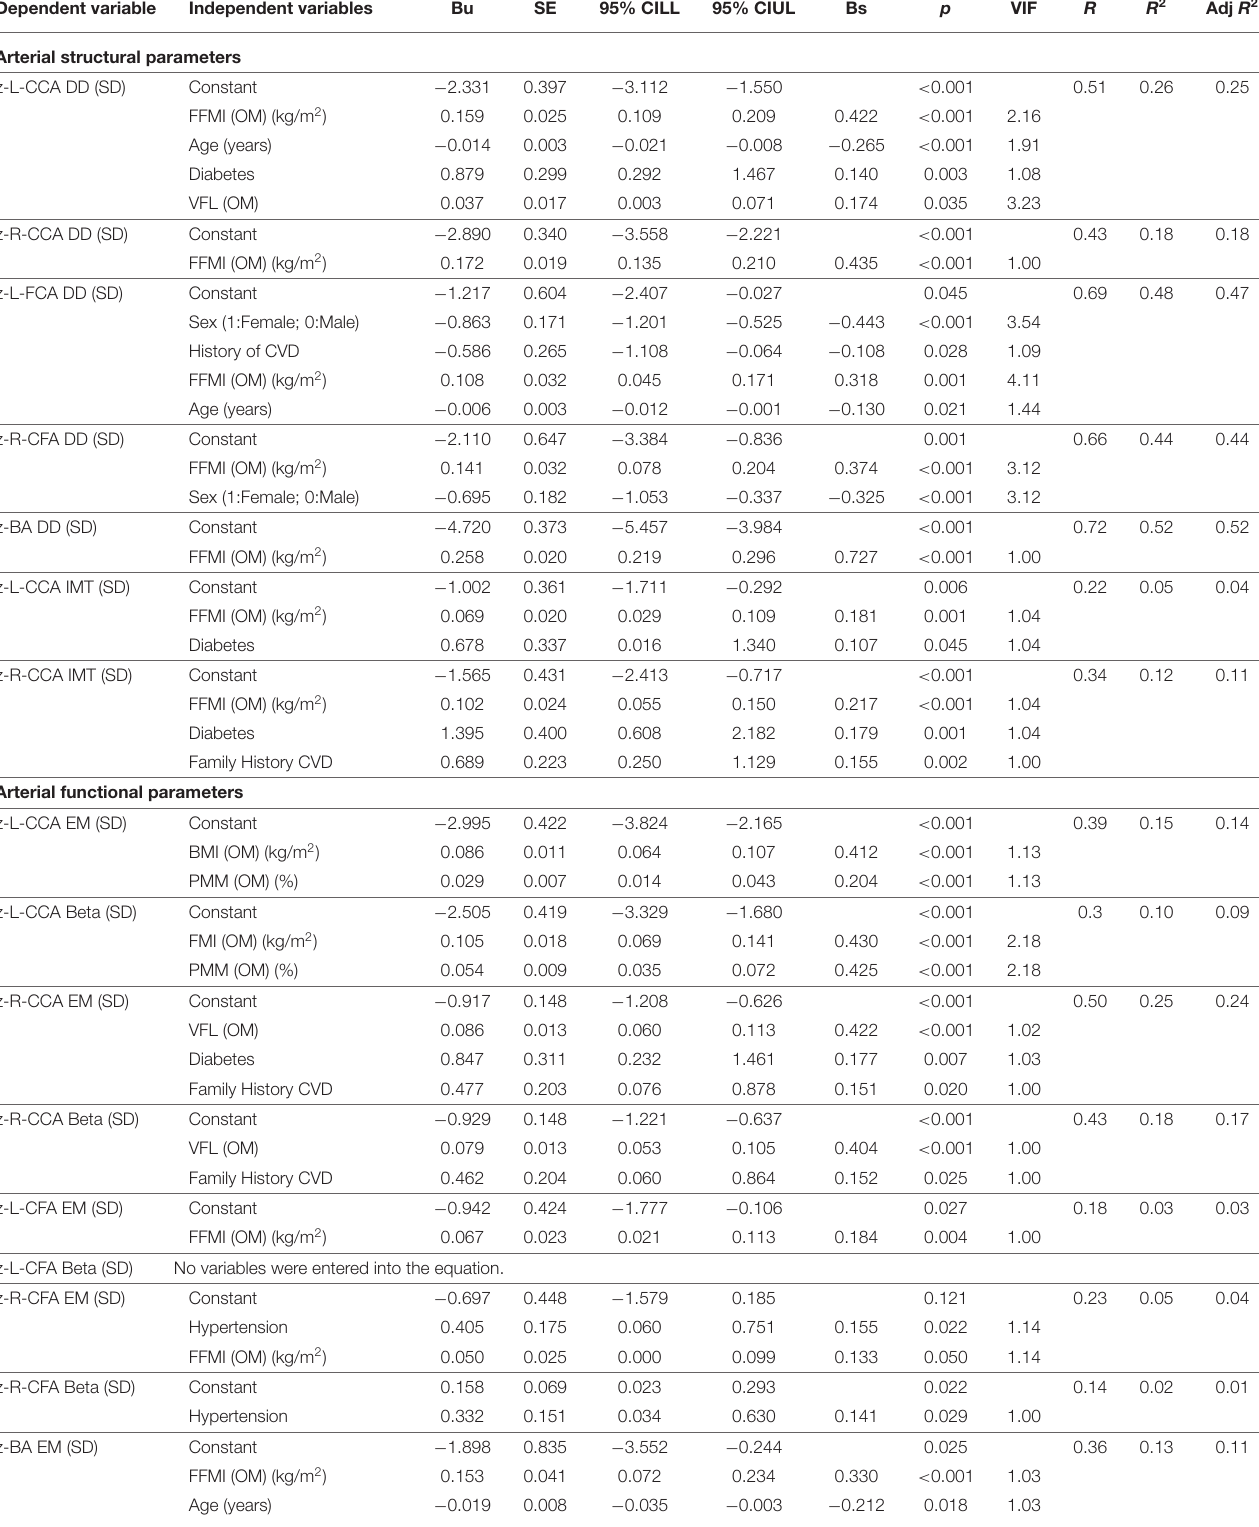
TABLE 2 | Association between cardiovascular z-scores (dependent variable) and cardiovascular risk factors, classical anthropometric and body composition indices (independent variables) (OMRON HBF-514C device). Dependent variable Arterial structural